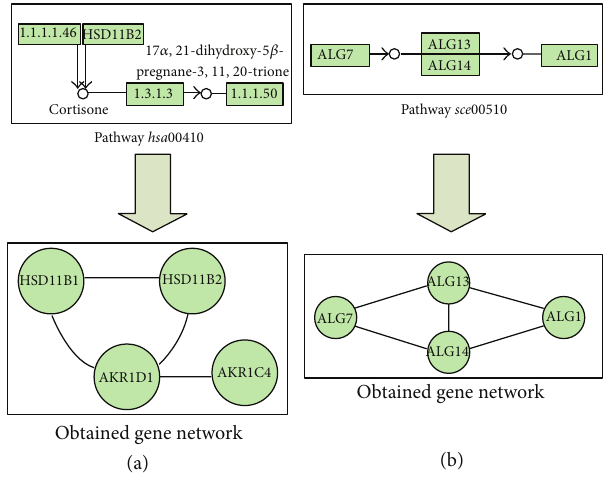
Figure 3: Two portions of real KEGG pathways with multicon- nected nodes. (a) contains a fragment of the pathway ℎ𝑠𝑎00410 where three genes are connected to the same compound. In the process of conversion to a gene network, new relationships between these genes are created. (b) shows a fragment of the 𝑠𝑐𝑒00510 pathway, illustrating how a compound is transferred by two genes. When the gene network is created, these two genes must be connected (as shown in the figure). Note genes HSD11B1, AKR1D1, and AKR1C4 (a) correspond to enzymes “1.1.1.146,” “1.2.1.3,” and “1.1.1.50,” respectively.